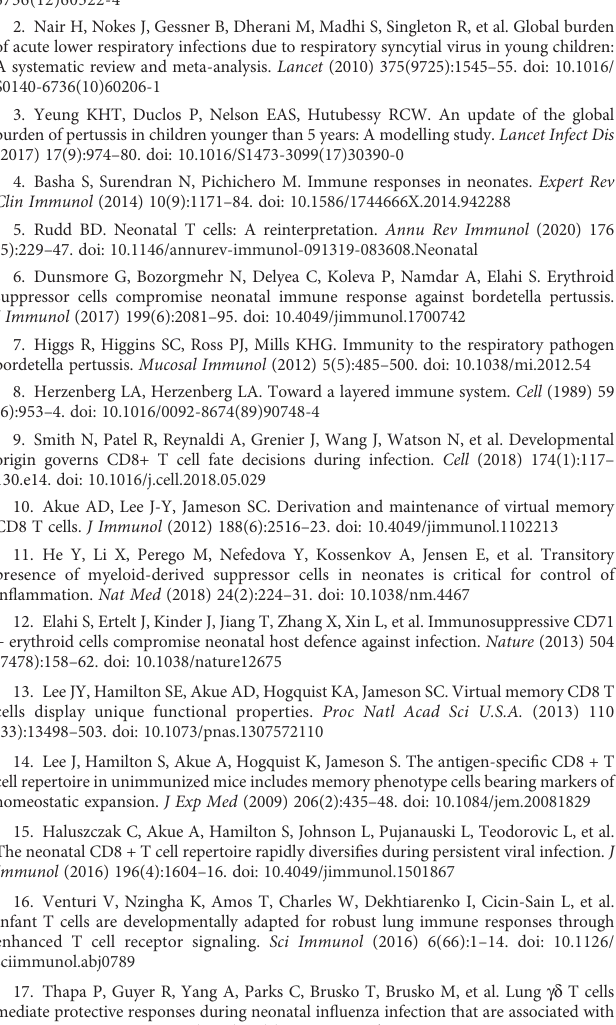
SUPPLEMENTARY FIGURE 4 Positive and negative controls for T VM panel. Positive control was assessed via T VM from P8 C57BL/6J pup lungs stimulated with PMA/ionomycin or unstimulated. Negative control was assessed via T VM from P8 T cell -/- pup lungs stimulated with PMA or unstimulated. Error bars show standard error of the mean, n=7-8. Statistical signi fi cance was calculated via Two-way ANOVA. ns p> 0.032 ***p<0.001. SUPPLEMENTARY FIGURE 5 P8 C57BL/6J pups have signi fi cantly lower proportions of naïve T cells (CD3 + Tcr g / d - CD4 + CD8 + CD44 lo CD49d lo ) than P10 C57BL/6J mice. Error bars show standard error of the mean, n=4. Statistical signi fi cance was calculated via One-way ANOVA. **p> 0.01 ****p<0.0001. SUPPLEMENTARY FIGURE 6 Puri fi ed pertussis toxin (PTx) partially rescues ability of Bp D ptx to cause disease in P5 neonatal mice. Log10 of CFU recovered from the lungs (A) and nasal cavity (B) from neonatal P5 C57BL/6J mice at 3 days post inoculation with WT Bp (blue), Bp D ptx (red), or Bp D ptx supplemented with puri fi ed PTx ( Bp D ptx + PTx) (purple) (n=4perstrain).Statistical analysiswascalculated via Two-way ANOVA.Errorbars show standard error of the mean. ns p> 0.0332, ***p< 0.0002, ****p< 0.0001.